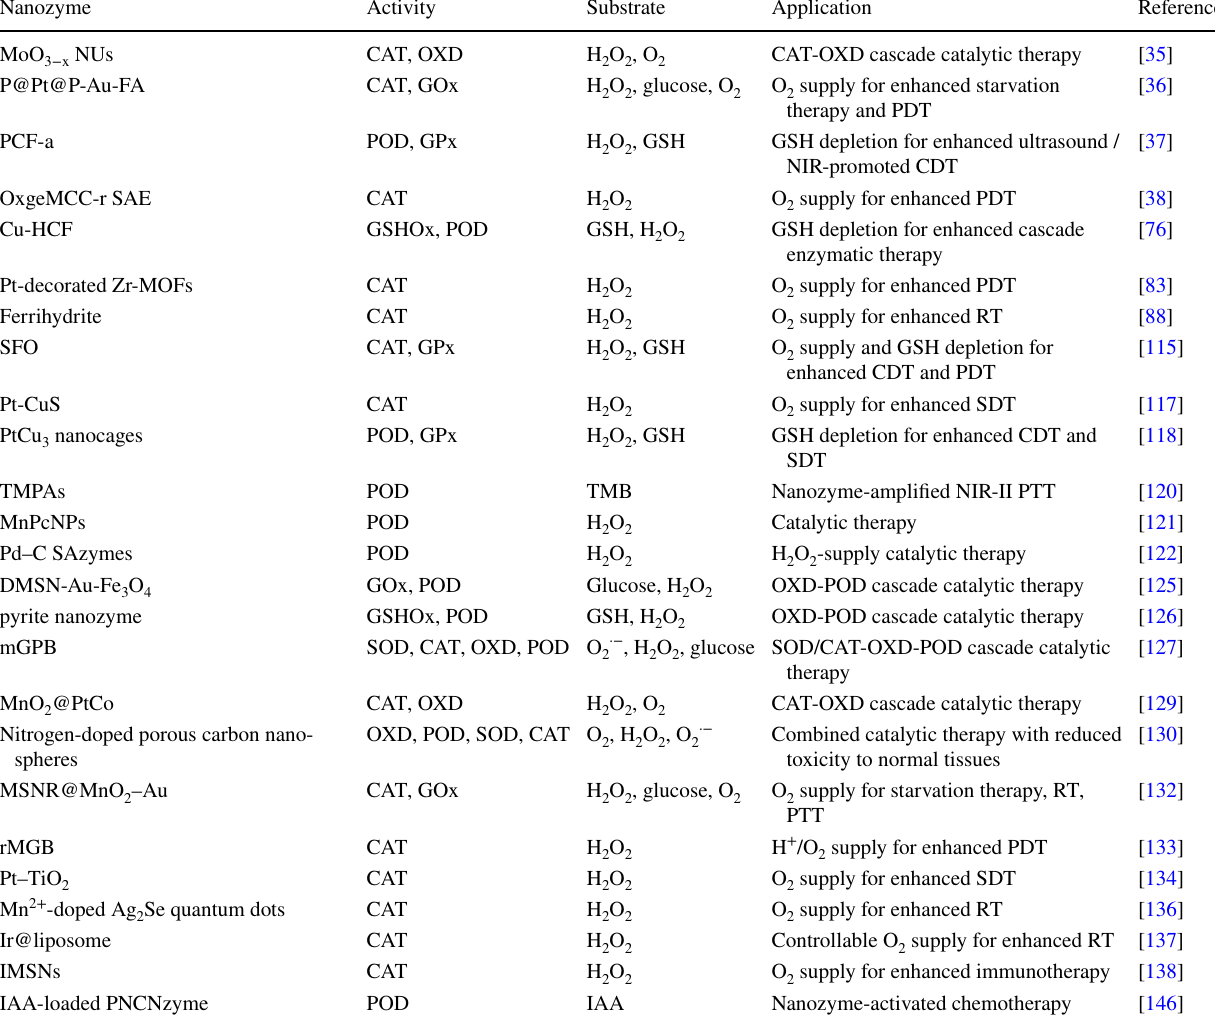
Table 6 Nanozymes for cancer therapy Nanozyme Activity